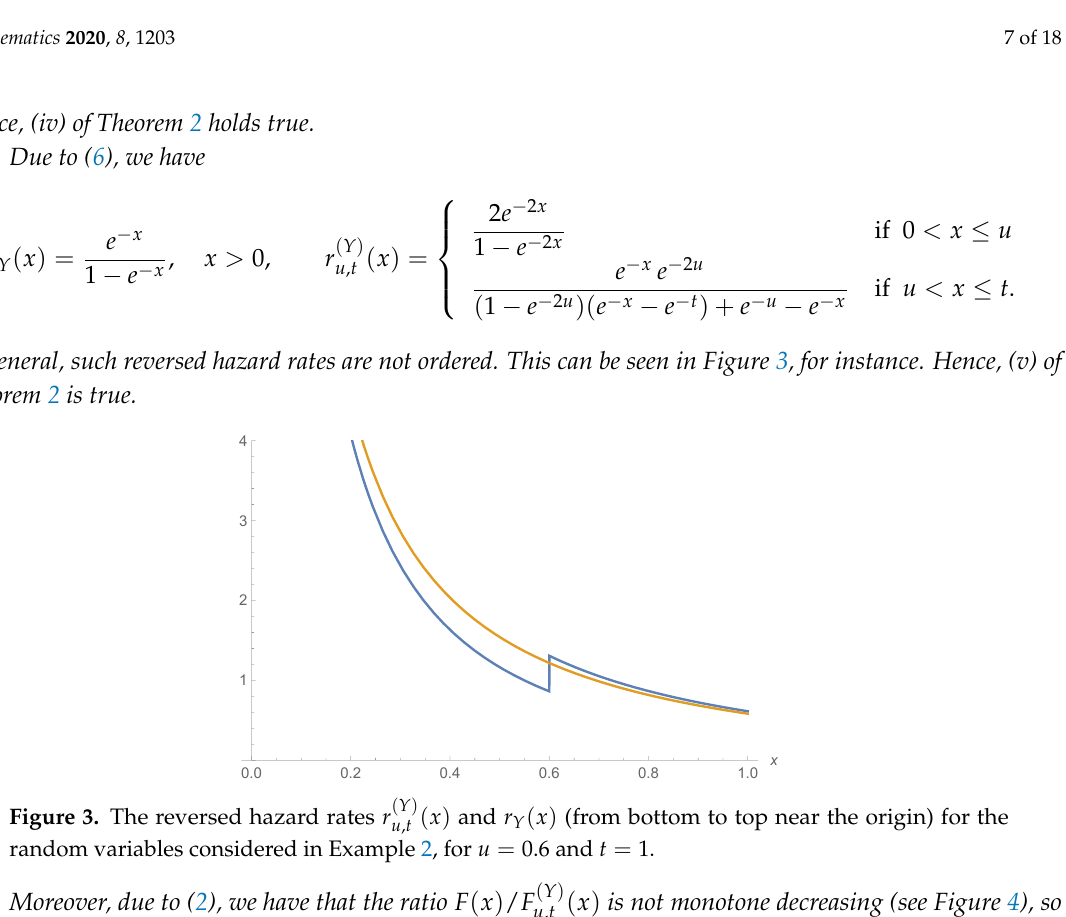
Figure 3. The reversed hazard rates r random variables considered in Example 2, for u = 0.6 and t = 1.